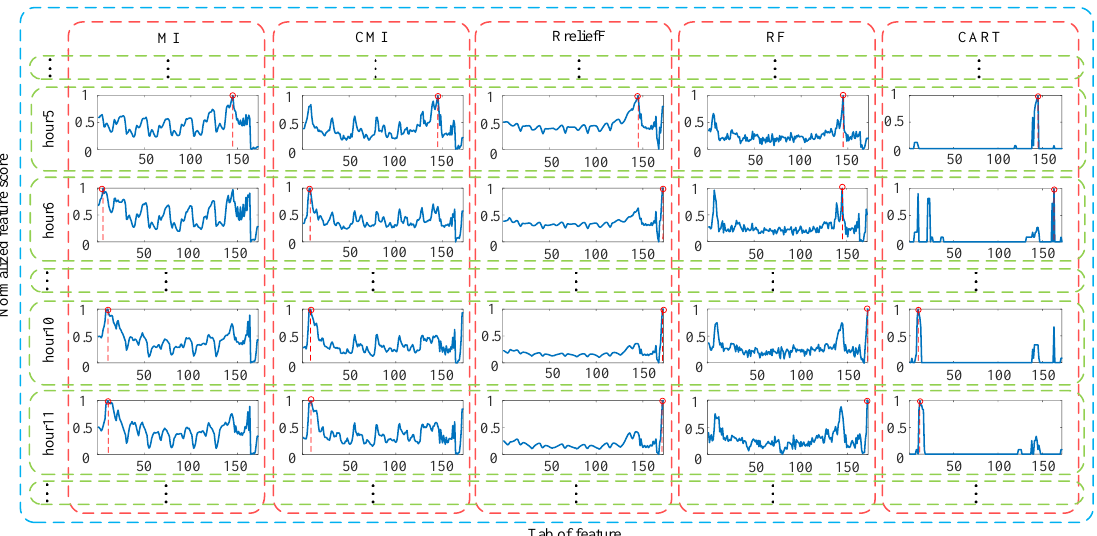
Figure 3. Normalized feature score of features evaluated by kinds of feature selection methods. Table 3. Top 10 features of ranked of feature by different feature selection corresponding to Figure